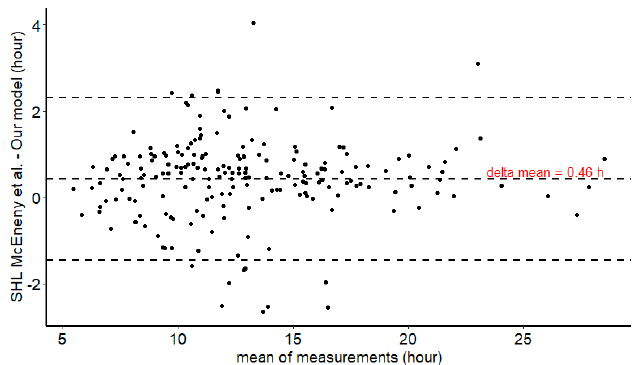
Figure 5. Bland Altman plot of half-life empirical bayes estimates (EBEs) of our model and McEneny- King’s et al.’s generic SHL model [21].